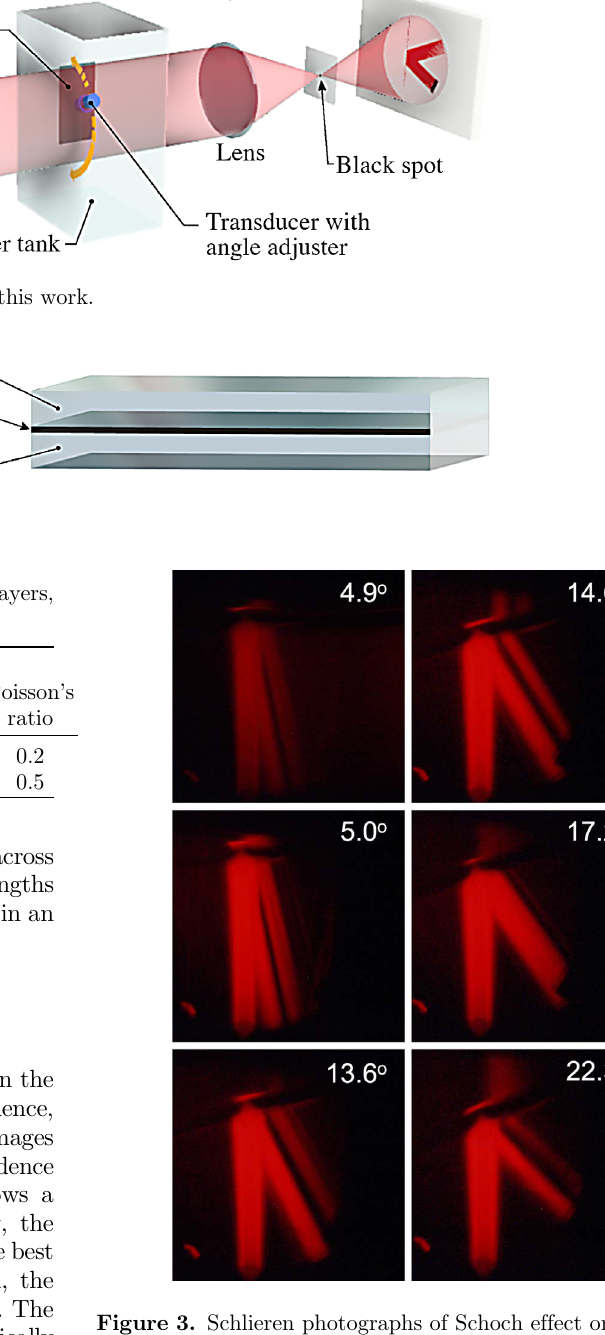
Figure 3. Schlieren photographs of Schoch effect on sample 1.